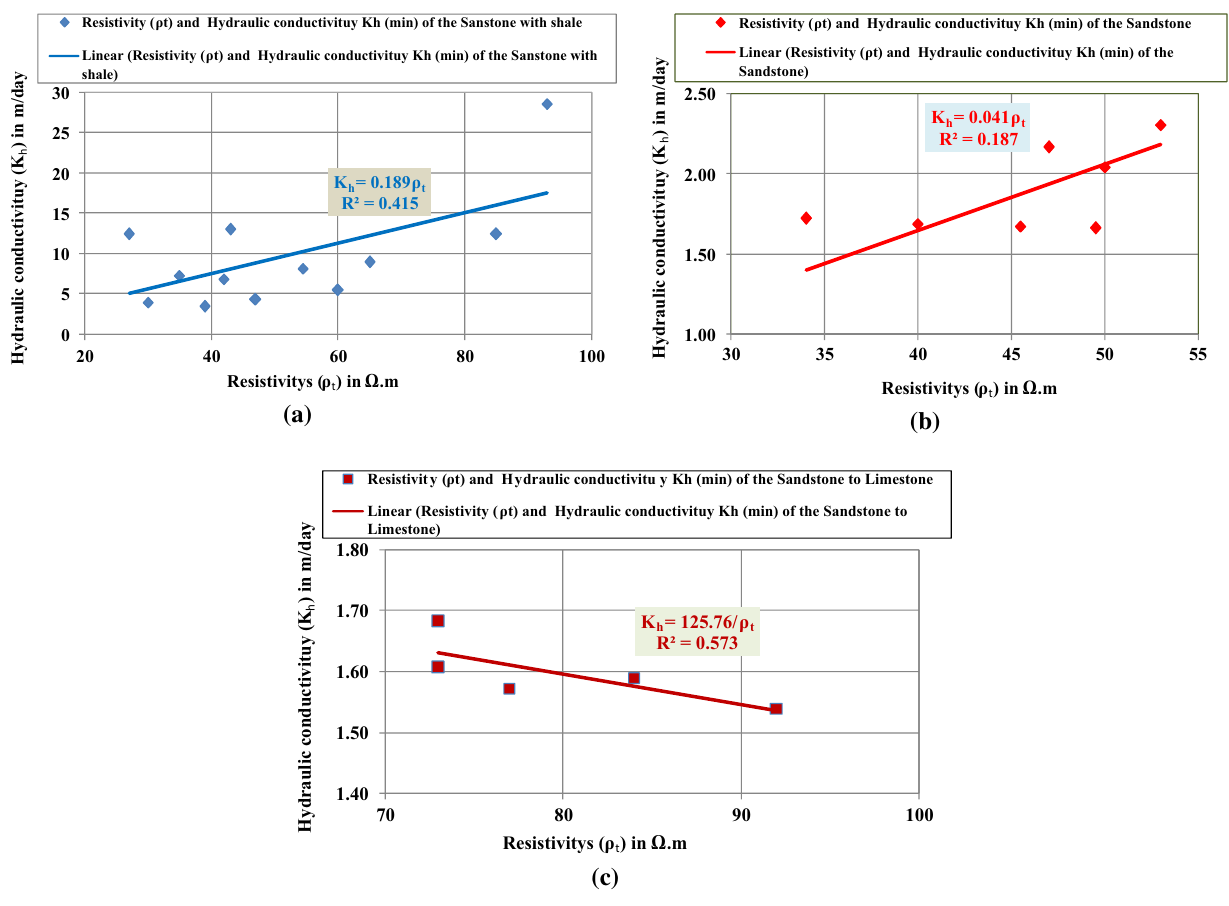
Fig. 12 Relationship between the resistivity ( ρ t ) in Ω m and the minimum hydraulic conductivity ( sandstone ( b ) and sandstone to limestone ( c ) Table 3 Resistivity ( ρ t ) in Ω m and the minimum calculated transmissivity ( Vertical electrical sounding station